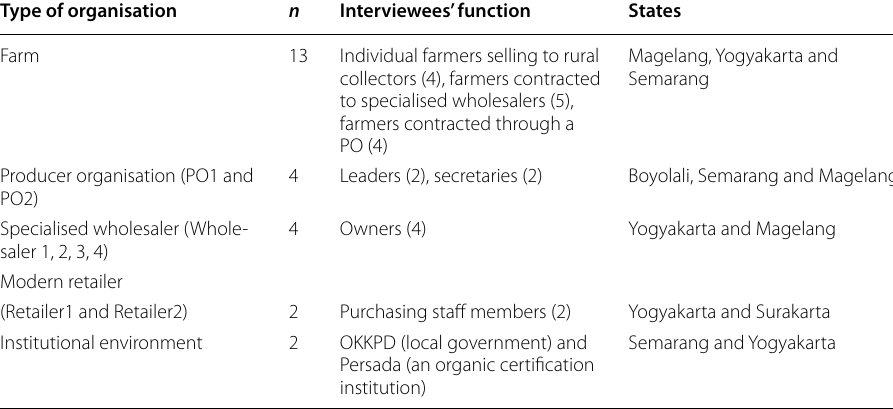
Otoritas Kompeten Keamanan Pangan Daerah (OKKPD) translates as the Regional Food Safety Competent Authority. It is an institution within the Agriculture Department and Food Security Agency in Central Java and is tasked with ensuring food safety and the quality of fresh food of plant